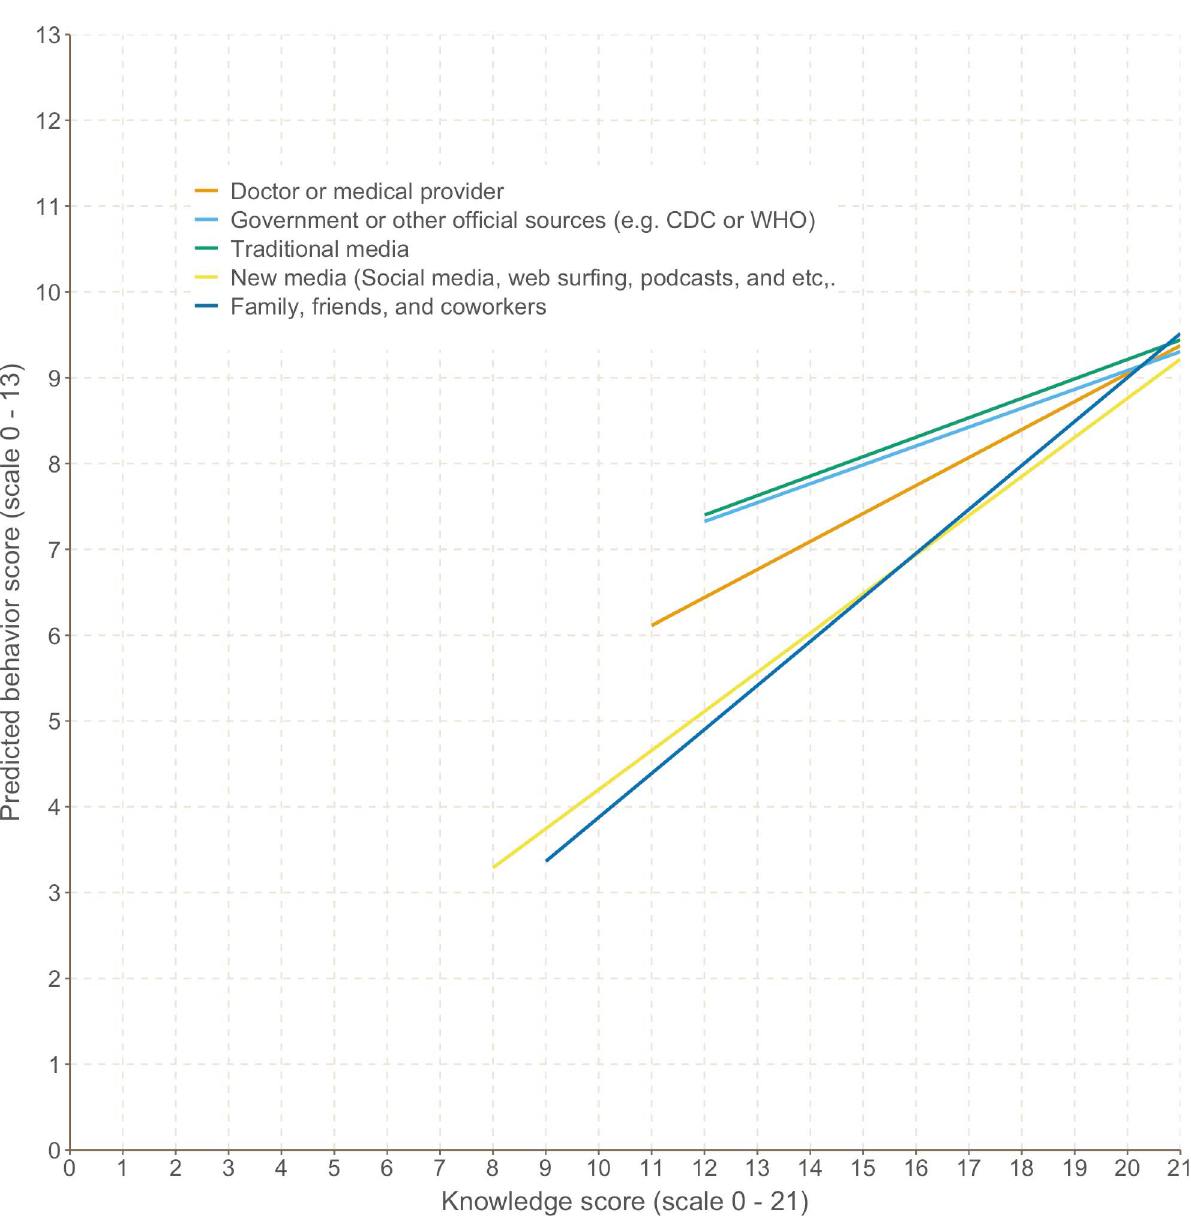
Fig 1. Fitted linear model for the association between COVID-19 knowledge (x-axis) and protective behaviors (y-axis) by primary information source of COVID-19.